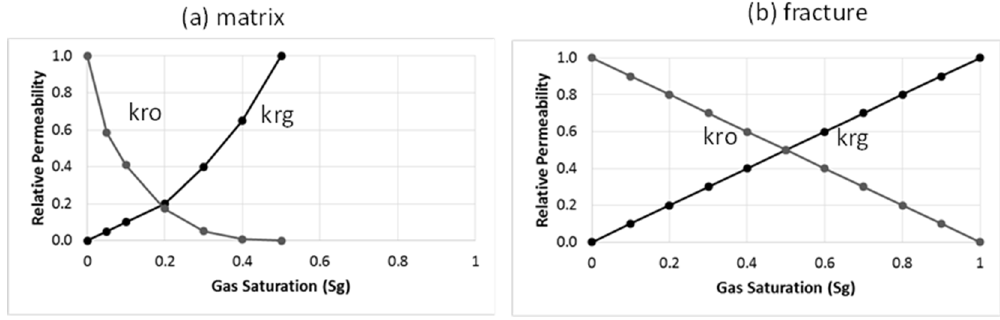
Figure 6. Relative permeability curves for ( a ) matrix and ( b ) fracture; kro is the oil relative permeability and krg is the gas relative permeability.